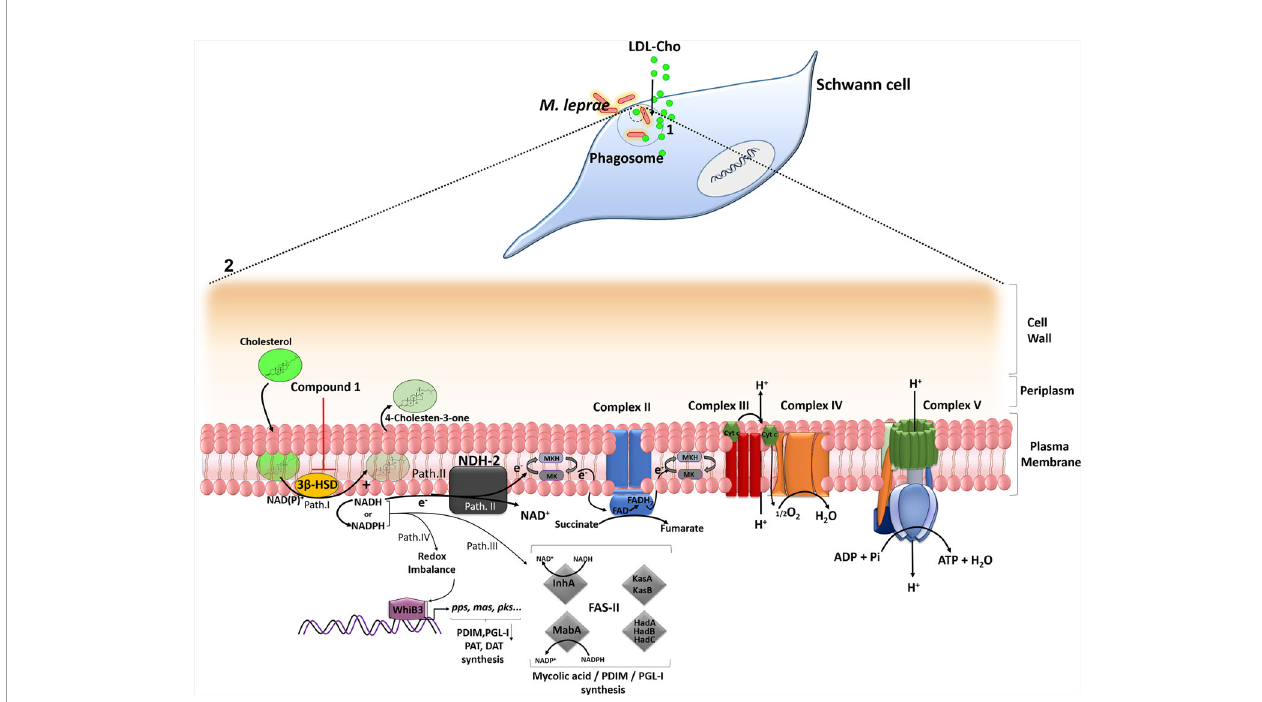
FIGURE 6 | A model proposing a key role of cholesterol oxidation for M. leprae survival inside SCs. (1) After internalization, M. leprae induces LDL-cholesterol (LDL- Cho) uptake that is recruited to bacterium-containing phagosomes. (2) Magni fi cation of M. leprae cell envelope. Path I - 3 b -HSD oxidizes cholesterol to cholestenone generating NADH, which can be converted to NADPH. Path II - NADH derived from 3 b -HSD feeds bacterial electron respiratory chain via type-II NADH dehydrogenase (NDH-2), which reduces menaquinone (MK) to menaquinol (MKH), a substrate of the succinate dehydrogenase (complex II). The proton motive force generated during electron transport chain will be used by the ATP synthase (complex V) to generate ATP. Path III – NADH/NADPH can be used by fatty acid synthase II (FASII) for the synthesis of PDIM and PGL-I. The FASII complex trans-2-enoyl-AcpM reductase (InhA) and b -ketoacyl-AcpM reductase (MabA) subunits use NADH and NADPH, respectively. Path IV - WhiB3, a probable transcriptional regulatory protein, senses variations in the redox balance through NADH and NADPH levels and activates the promoter region of polyketide biosynthetic genes inducing the synthesis of mycobacterial lipids such as polyacyltrehaloses (PAT), diacyltrehaloses (DAT), PDIM and PGL-I. Inhibition of 3 b -HSD by compound 1 reduces the levels of NADH/NADPH affecting the metabolic pathways described and impacts M. leprae intracellular viability. The arrows indicate some of the destinations of NAD(P)H already described in the literature and propose routes fed by the reducing power generated from 3 b –